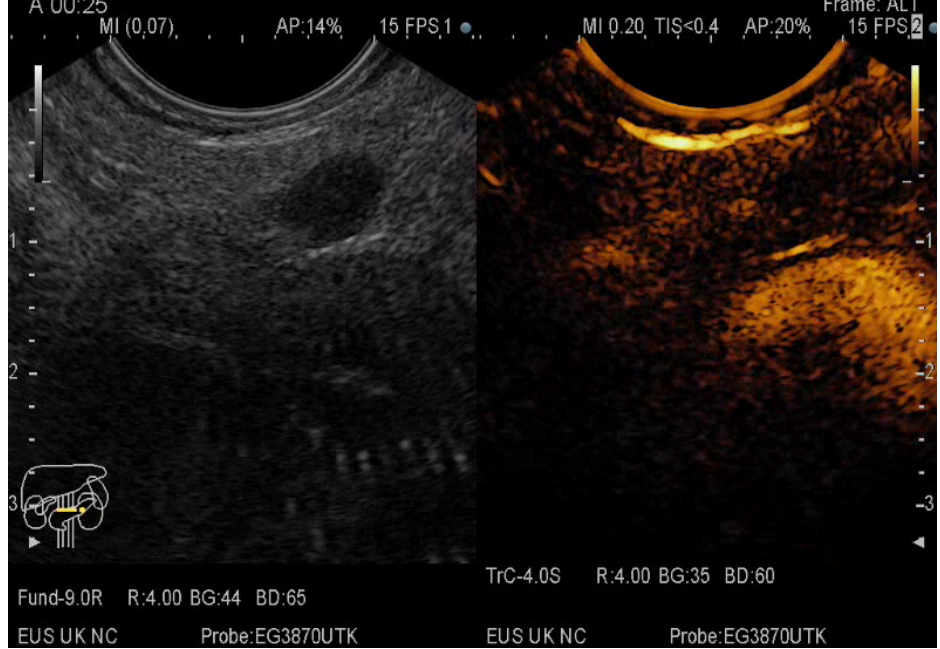
Figure 5. CE-EUS image of a pNET revealing an isoenhancing solid mass in the arterial phase and a discrete wash-out in the venous phase.